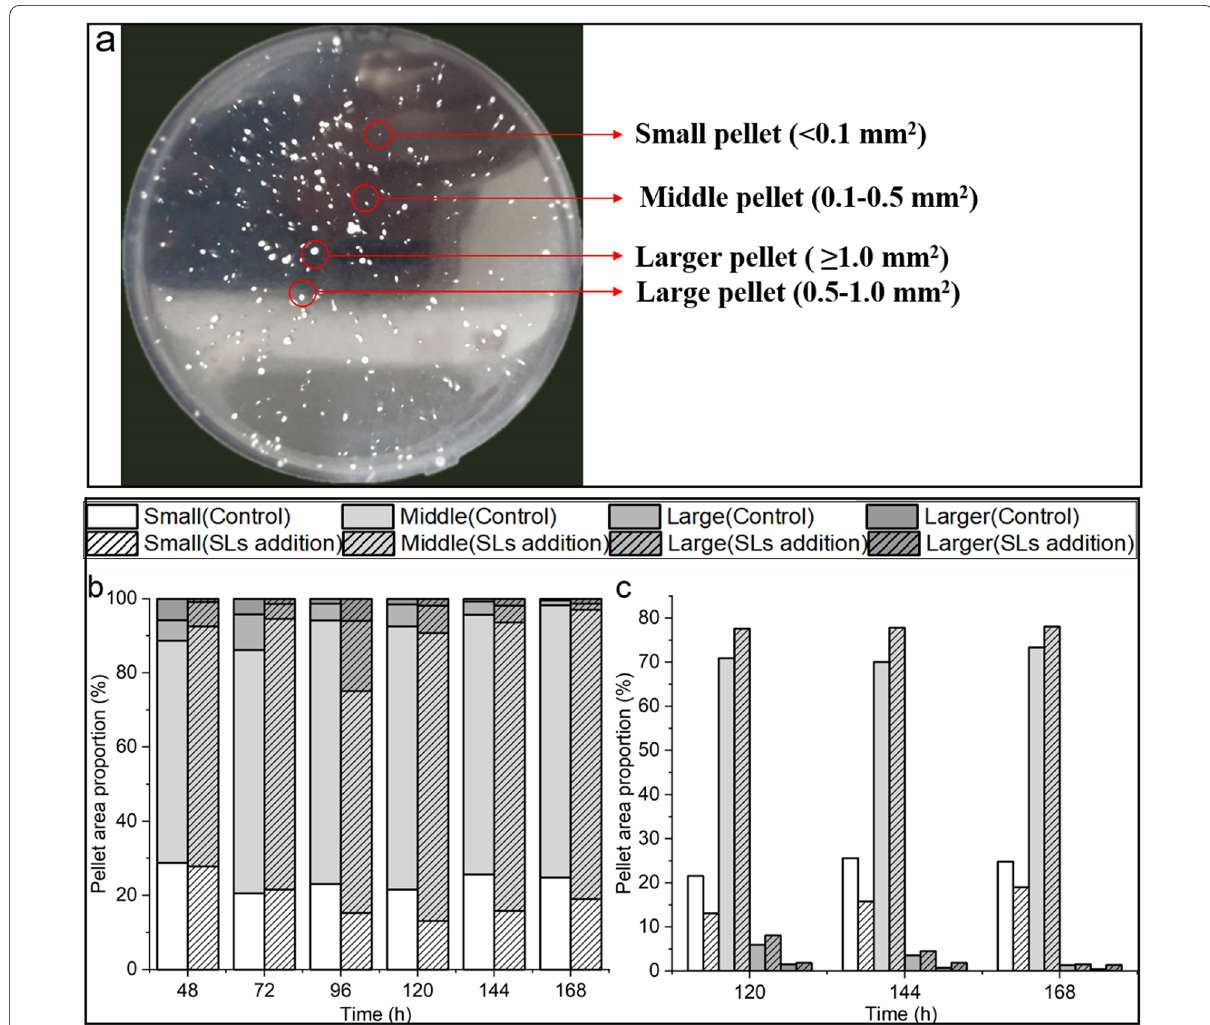
Fig. 4 Definition of four types of pellets and comparison between control group and SLs addition group. a The photo of A. oryzae pellets laid on an agarose plate. b Stacked column chart showing the proportion and their change of four kinds of pellets during the whole fermentation process. c The bar graph showing the difference of four kinds of pellets proportion between the control group and SLs addition group during the rapid enzyme production